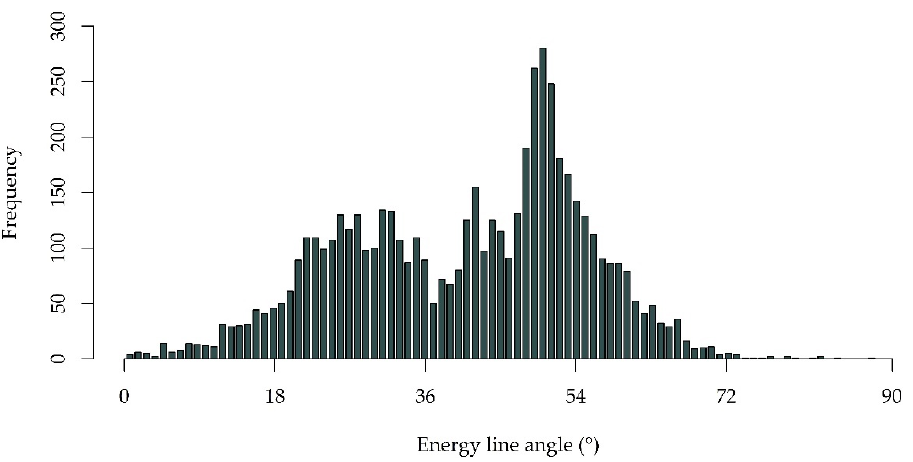
Figure 8. Energy line angles (°) for rockfall deposits in the Alpine Space.